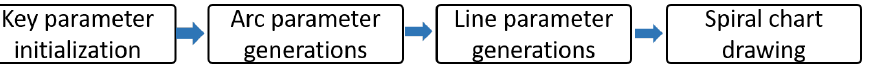
Figure 3. The steps for drawing RadialNet. Reprint with permission from Jianlong Zhou, Weidong Huang and Fang Chen (2020). Copyright 2020 IEEE Pacific Visualization Symposium